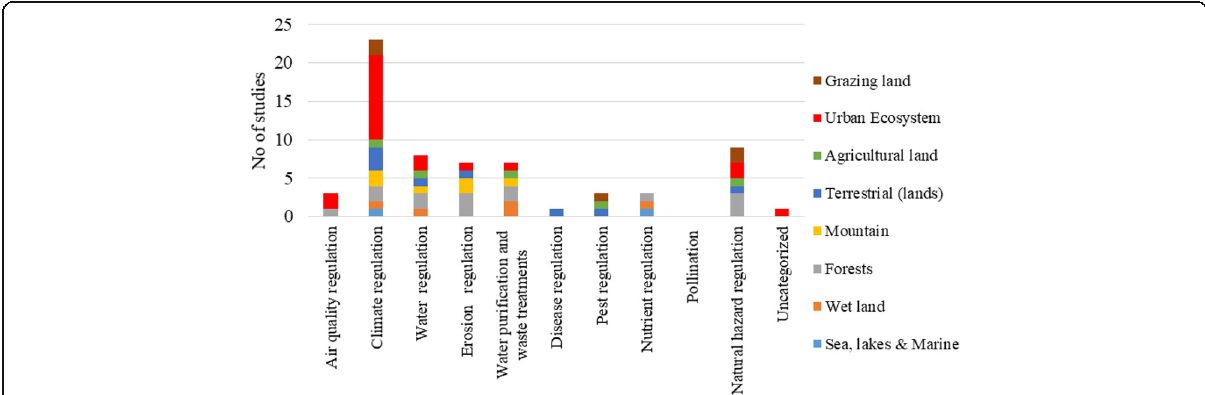
Fig. 3 The number of case studies and RES indicators based on MA 2005 classification. Based on indicators of RES, climate regulation and natural hazards were relatively well studied, whereas the pollination, pest, and disease regulation services were the least studied. Based on the studied ecosystems, urban and forest ecosystems had more case studies compared to sea/marine, wetlands, and grazing